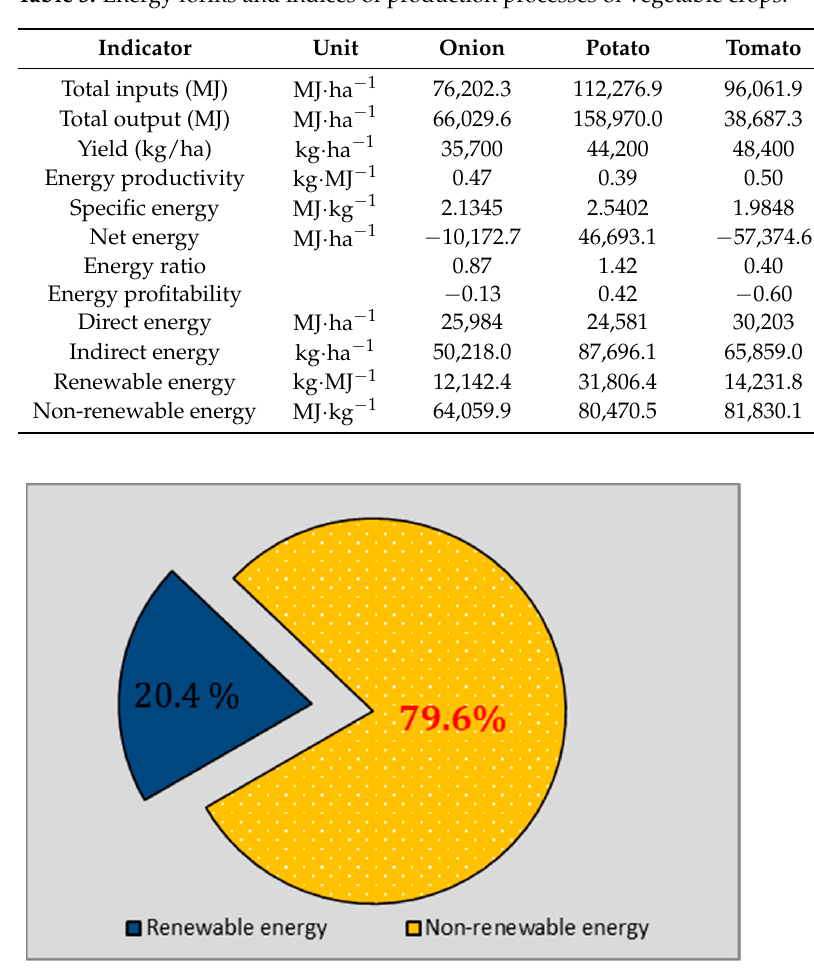
Figure 4. Comparison between the main contributions of renewable and non-renewable consumed energy in the production of vegetable crops.